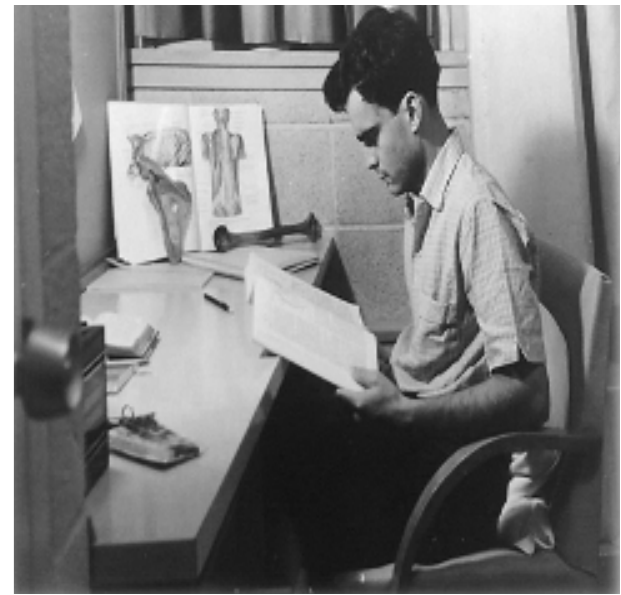
Fig. 4 - Tomas as a medical student at McGill University.